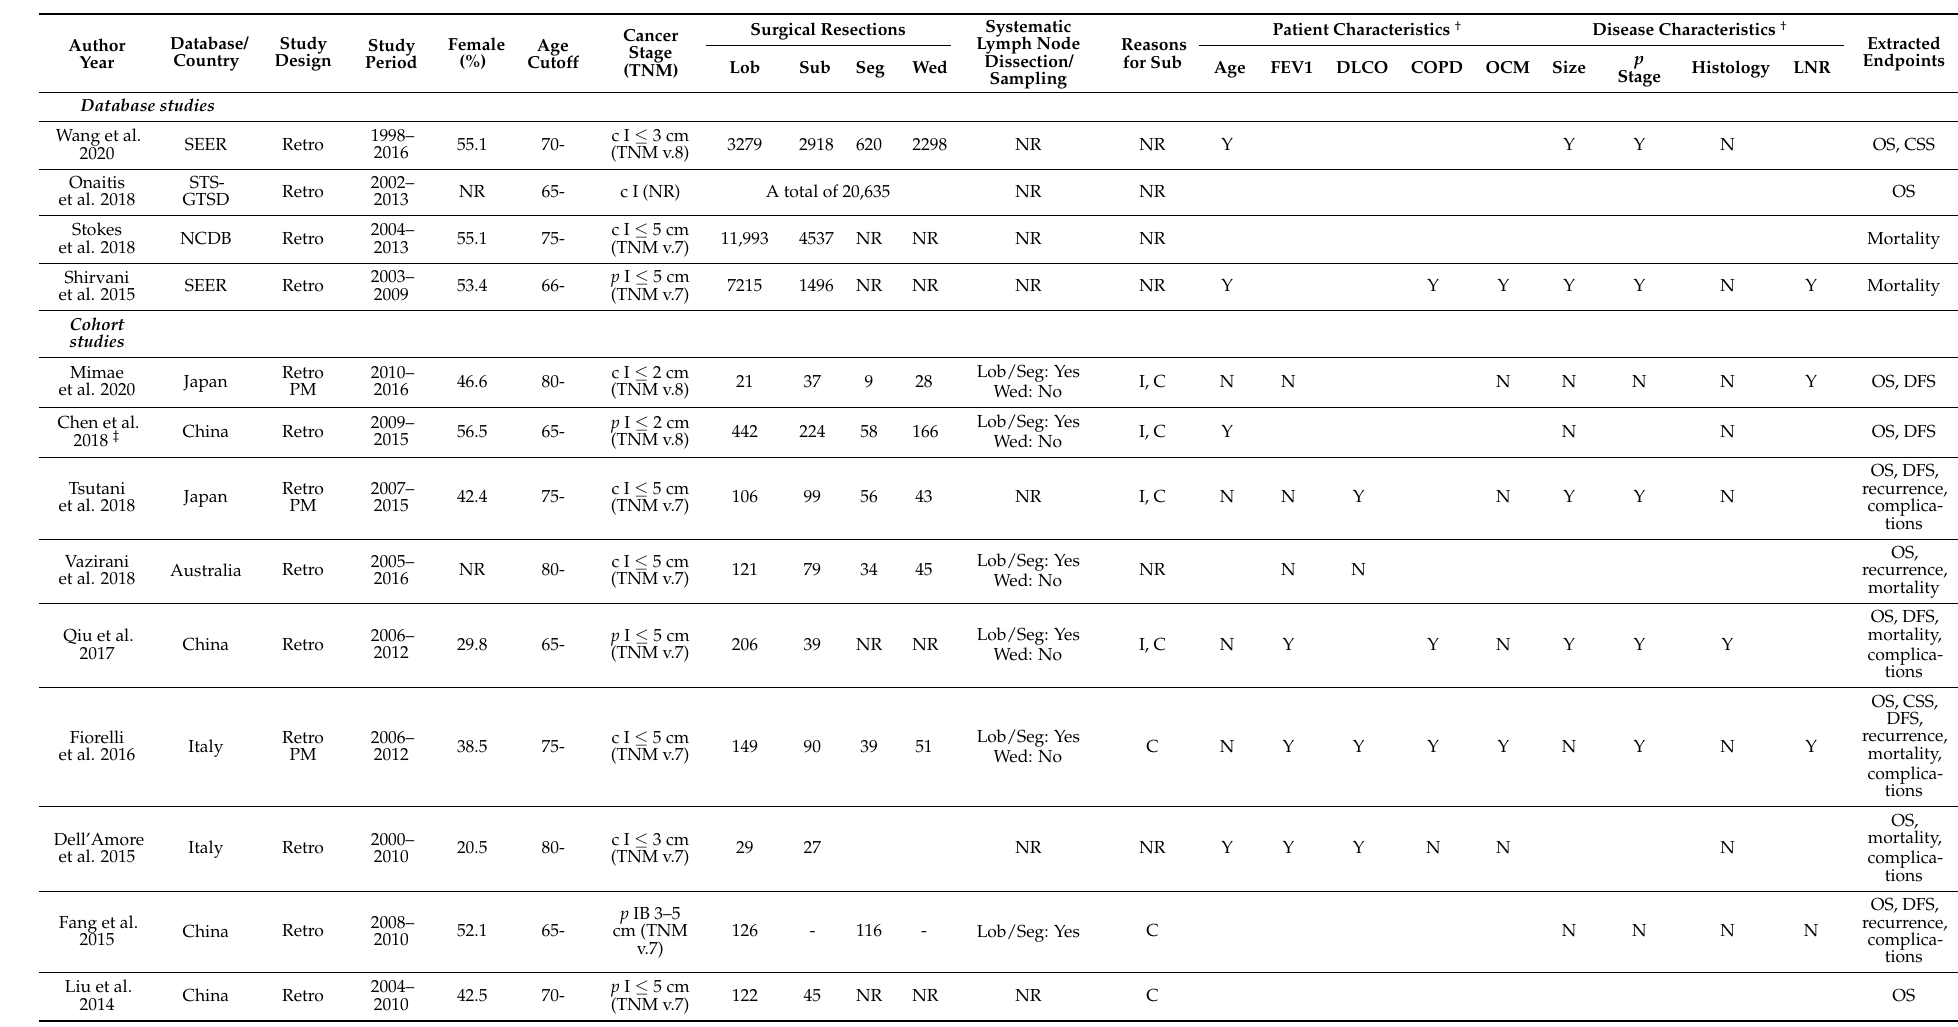
Table 1. Characteristics of included